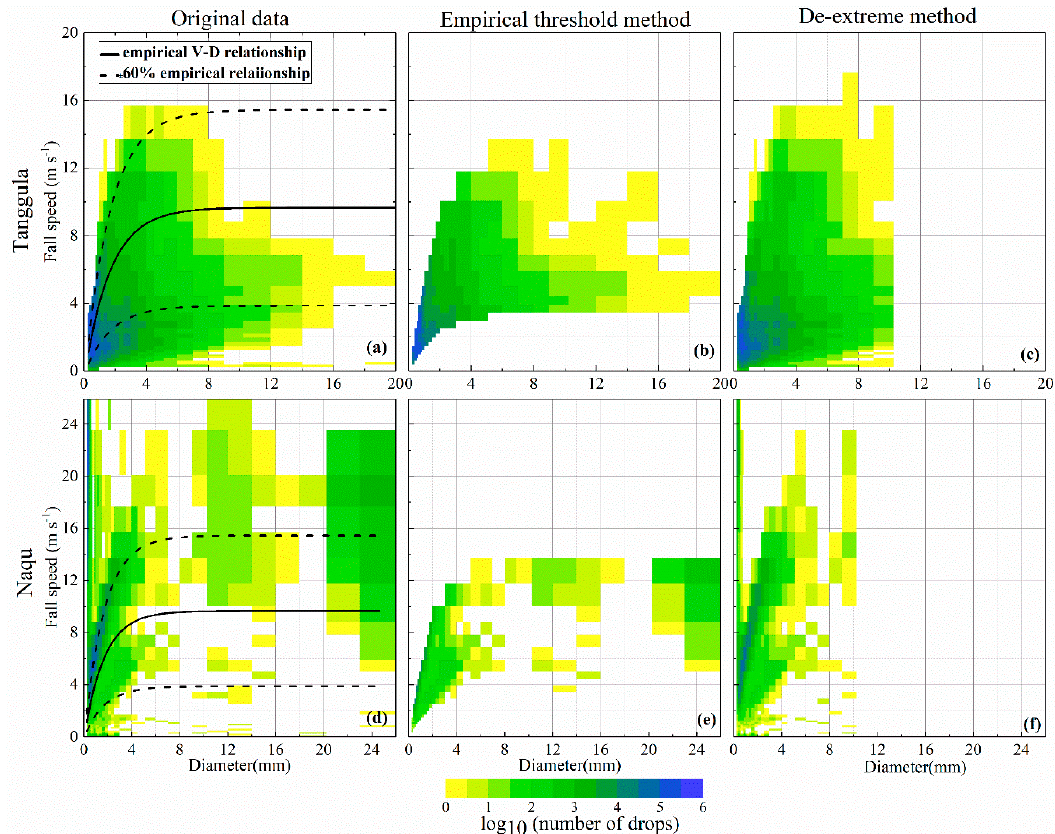
Figure 2. Comparison of the raindrop size distribution (DSD) and data quality control schemes in Tanggula and Naqu from July to August 2015. ( a – c ) DSD based on original data, the empirical threshold method, and the de-extreme method in Tanggula. ( d – f ) DSD based on the original data, empirical threshold method, and de-extreme method in Naqu. The solid line indicates the V–D empirical relationship, and the dashed lines indicate the ±60% V–D relationship. The V–D relationship is the empirical fall velocity–diameter relationship of Atlas et al. [37].